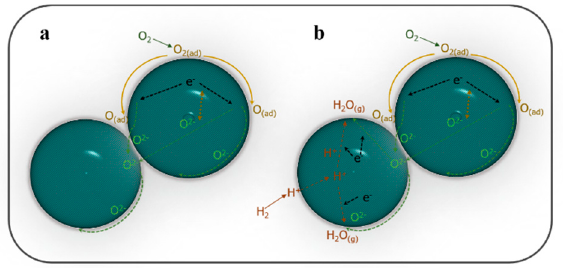
Figure 4. Schematic illustrations of ( a ) oxygen species transport and ( b ) mixed H + and O 2 − transport enhanced by electron transfer in LCF.